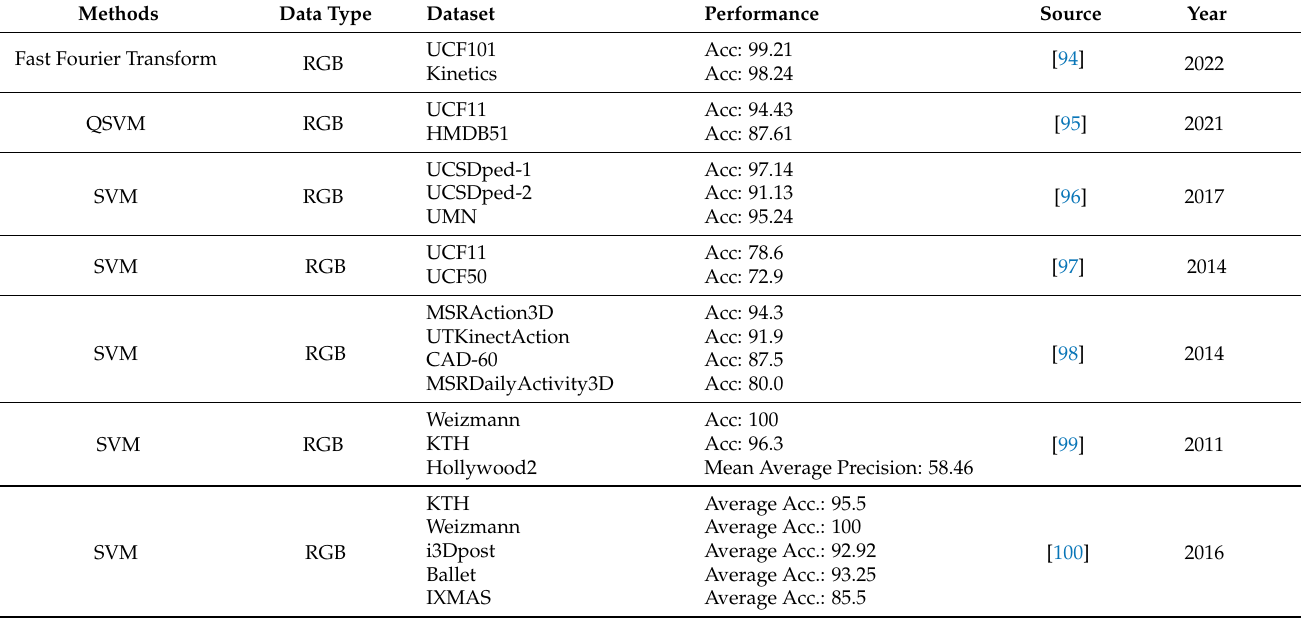
Table 1. Handcrafted feature-based state-of-the-art methods for action recognition.